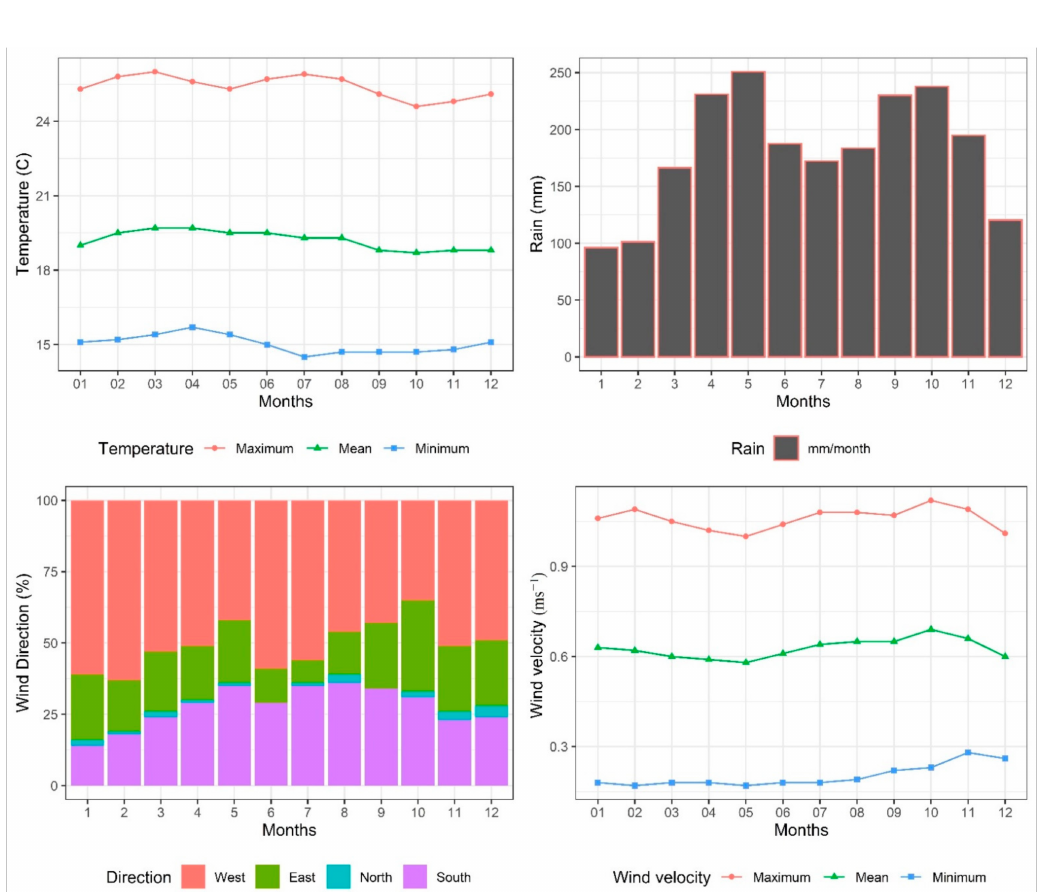
Figure 3. Multiannual variation on a monthly scale of the main climate variables in the study